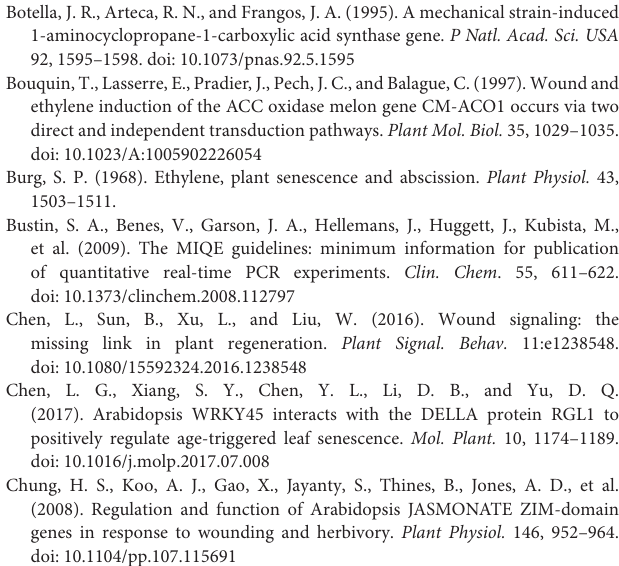
Supplementary Figure 2 | Identification of differentially expressed genes among all treatments during the onset of floral senescence. Supplementary Figure 3 | Biochemical characteristics and spatiotemporal expression analysis of RhWRKY33. Supplementary Figure 4 | Display of DEGs relating to transcription factors, protein modification, protein degradation (A) , and hormone signaling (B) was specifically regulated by Group 3. Supplementary Figure 5 | Effects of different hormone treatments on the expression of RhWRKY33 . Supplementary Table 1 | Statistics of annotation results for rose unigenes. Supplementary Table 2 | Detailed information of DEGs involved in hormone biosynthesis and signaling transduction pathway. Supplementary Table 3 | Detailed information of DEGs related to transcription factors. Supplementary Table 4 | Detailed information of DEGs relating to transcription factors, protein modification, protein degradation (A) , and hormone signaling (B) was co-regulated between Groups 2 and 3.